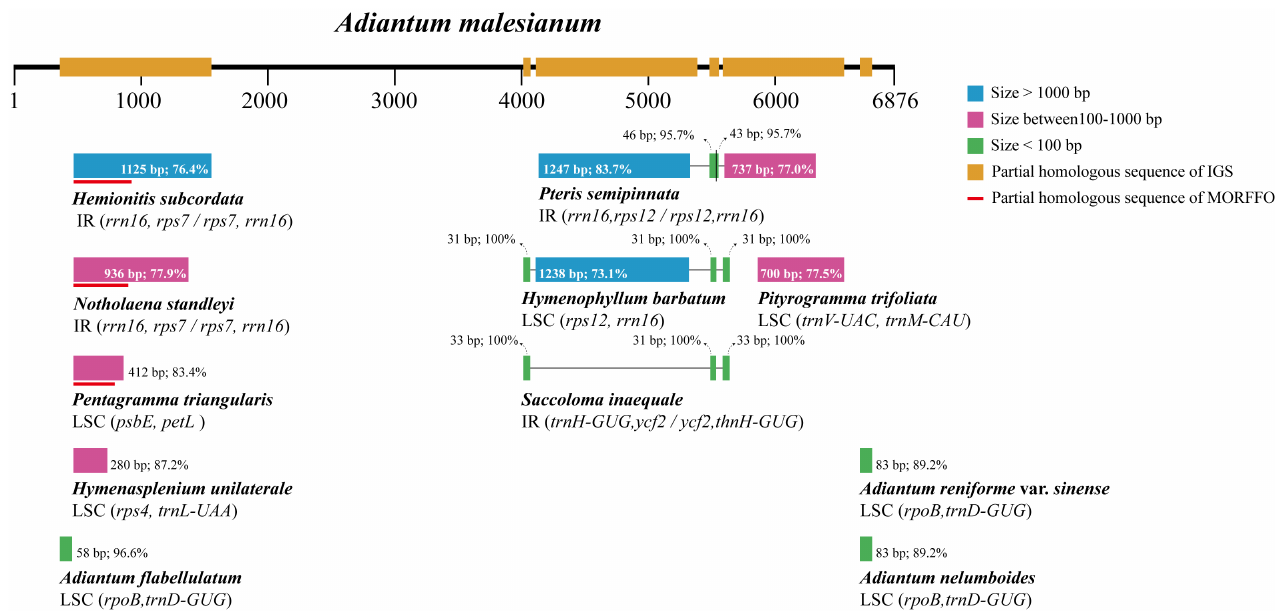
Figure 3. The schematic diagram of the location of homologous sequences included in the large rpoB - trnD - GUC IGS of A. malesianum . Gray lines connect different homologous sequences of one